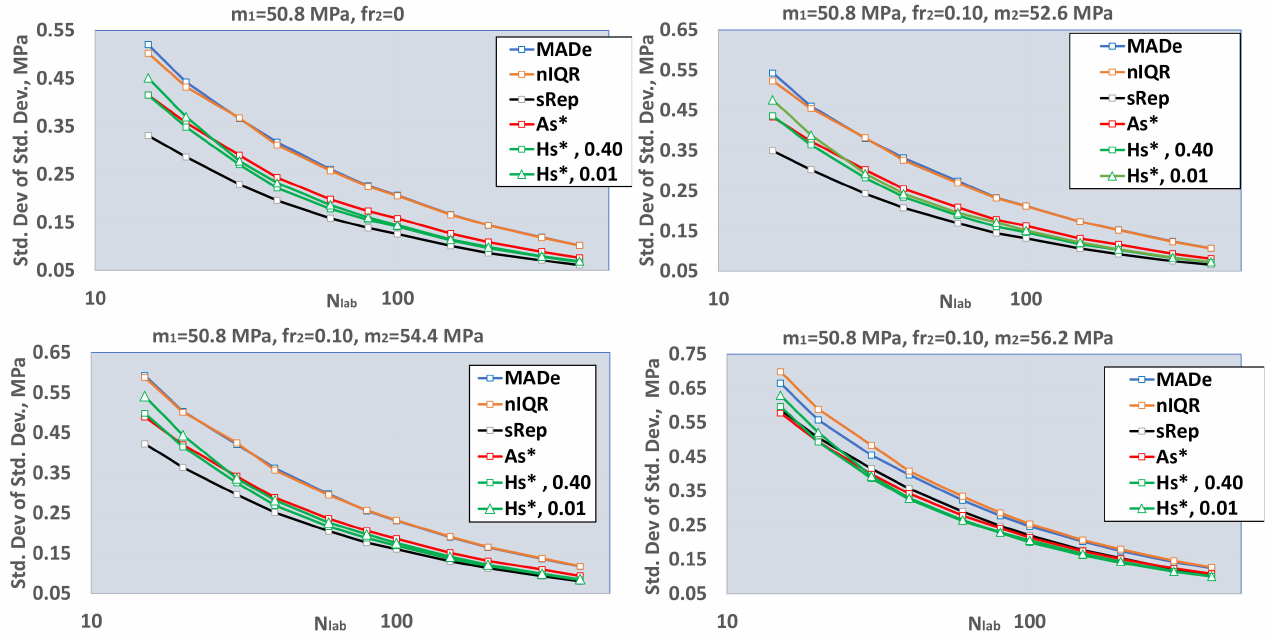
Figure 6. Standard deviations of the population standard deviations. MADe : scaled median absolute deviation; nIQR : normalized interquartile range; sRep : reproducibility standard deviation without outliers; As* : standard deviation—Algorithm A; Hs* , 0.40: standard deviation using Q method and s r = 0.40; Hs* , 0.01: standard deviation using Q method and s r =